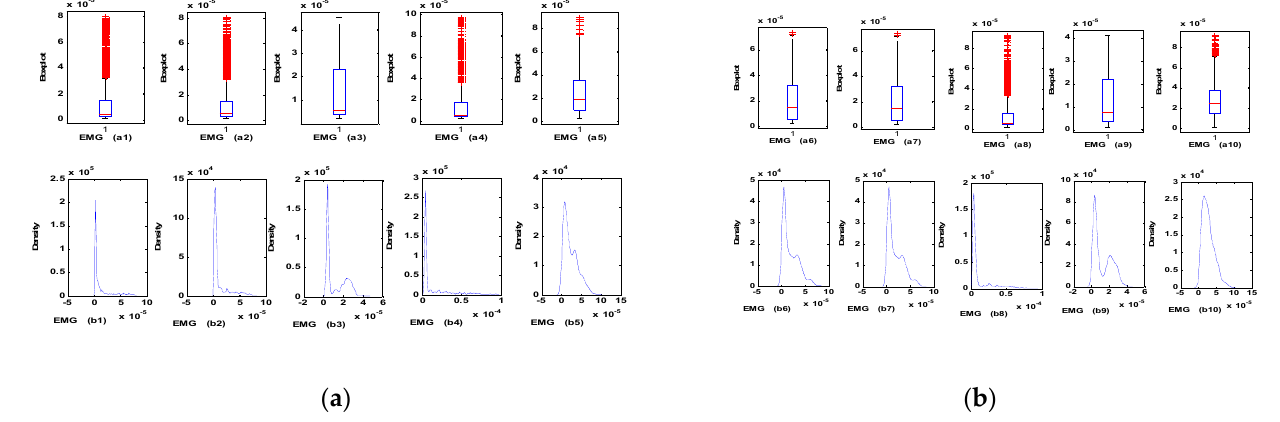
Figure 6. Data analysis (box plots and density profiles) of EMG signals for the movement “Two linear ramps.” ( a ) Box plot of the EMG signal i ( b ) density of EMG signal i